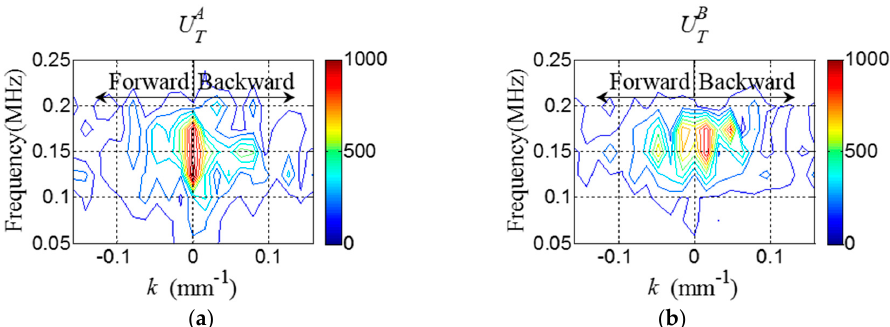
Figure 14. f-k domain plots ( a ) (cid:1847) (cid:3021)(cid:3002) and ( b ) (cid:1847) (cid:3021)(cid:3003) obtained from the cracked area of the specimen at 150 kHz.